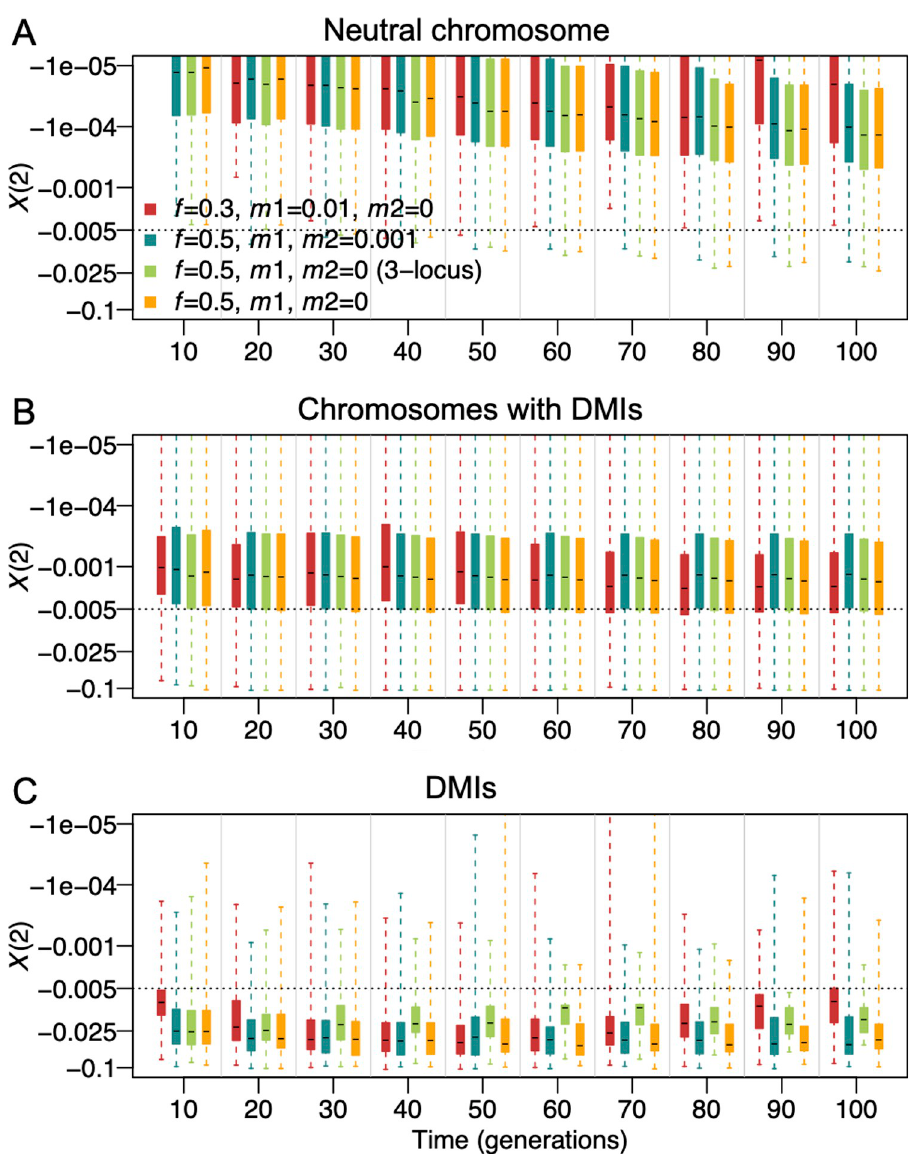
Fig 6. Distributions of negative X (2) when D ’ < 0 for DMI detection under four demographic scenarios. This figure represents two starting frequencies of the minor parental population, f = 0.5 and f = 0.3, and different immigration rates from the two parental populations ( m 1 from minor parental population, m 2 from major parental population). Light green boxes show the X (2) distribution for the three-locus two-DMI model (3-locus) and other boxes for the four-locus two-DMI model. DMIs are randomly distributed on four chromosomes. Direct selection coefficients of the incompatible alleles were drawn from an exponential distribution with mean = 0.001. Epistatic coefficients were drawn from a uniform distribution [-1, -0.001]. We calculated X (2) statistics from a sample of two hundred individuals for each simulation. We simulated each scenario 100 times with SLiM. X (2) values were summarized at three types of genomic regions, neutral chromosomes (A), chromosomes with DMIs (B), and individual DMI loci (C). Boxplots represent the interquartile range; whiskers extend to minimal and maximal values. The dashed line indicates the studied detection threshold X (2) = −